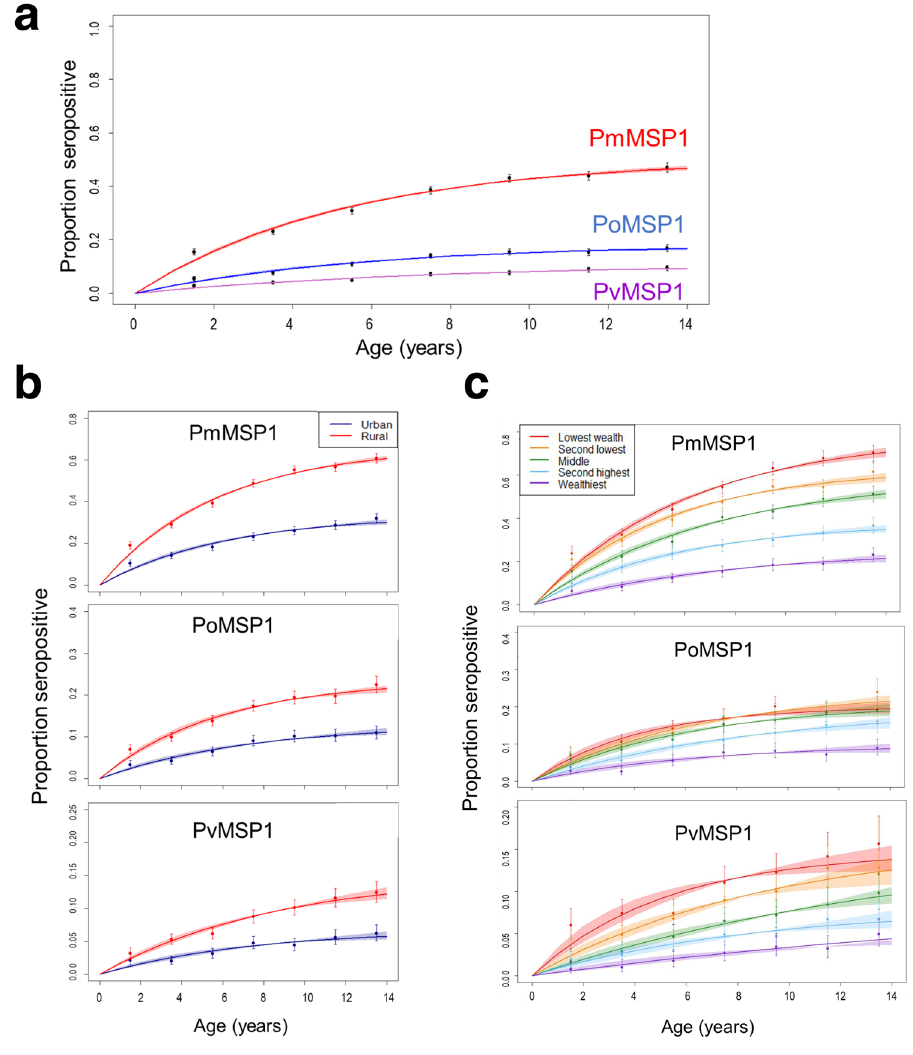
Fig. 5 | Seropositivity by age for IgG against PmMSP1, PoMSP1, and PvMSP1 antigens among children under 15 years: Nigeria, 2018. All participants ( a ), and as separated by urban or rural residence ( b ), or wealth quintile ( c ). Dots represent the proportion seropositive and error bars represent the 95% con fi dence intervals